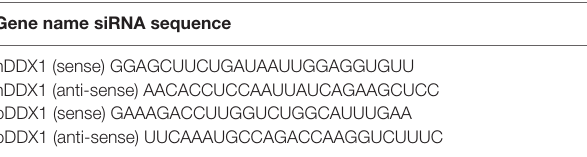
TaBle 1 | Small interfering RNA (siRNA) sequences used in this study. gene name sirna